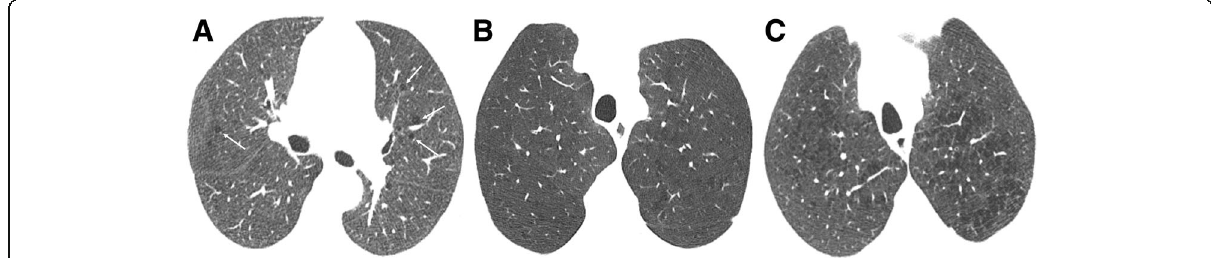
Fig. 4 Subtypes of CLE according to the Fleischner Society guidelines on HRCT. Axial images in 3 smokers show a trace CLE, with minimal centrilobular lucencies occupying less than 0.5% of a lung zone (arrows); b mild CLE, defined as scattered centrilobular lucencies affecting 0.5% to 5% of a lung zone; and c moderate CLE, with numerous centrilobular lucencies occupying more than 5% of any lung